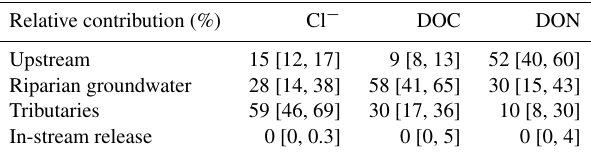
Figure 5. Relationship between dissolved organic carbon (DOC) and dissolved organic nitrogen (DON) concentrations in stream wa- ter and riparian groundwater (GW). Symbols are median values and whiskers are 25th and 75th percentiles for each sampling date. The black line shows the DOC vs. DON linear relationship for stream water and riparian GW samples pooled together for the non-LLF period (ANOVA, F = 16.6, d f = 13, p = 0.0015). The relationship was not significant for the LLF period. Table 2. Median and interquartile range [25th, 75th] of the relative contribution of inputs from upstream ( Q top × C top /F in ), tributaries ( Q tr × C tr /F in ), net riparian groundwater ([ Q gw × C gw > 0 ] /F in ), and in-stream release ( [ U × A < 0 ] /F in ) to stream solute fluxes at the whole-reach scale. Note that relative contributions from differ- ent sources do not add to 100% because they are medians rather than